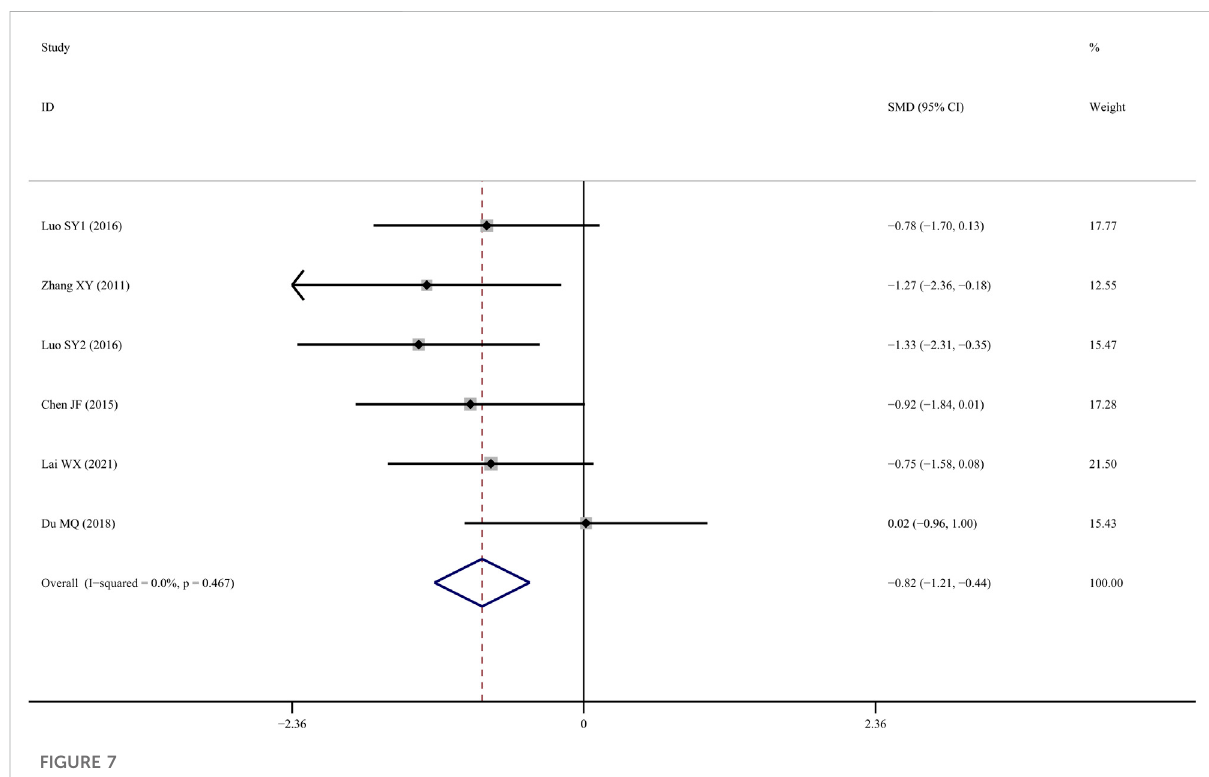
FIGURE 7 Effect of tanshinol on Tb.Sp change in OP